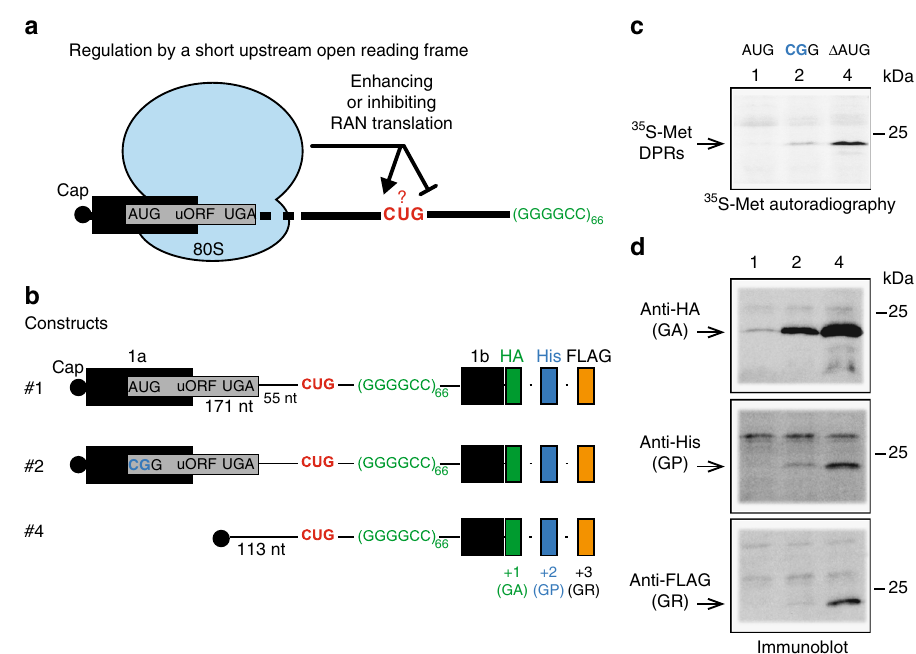
Fig. 5 RAN translation of G 4 C 2 repeats is down-regulated by a short upstream open reading frame (uORF). ( a ) Retention of intron 1 in C9ORF72 repeat- containing transcripts creates an uORF located 226 nucleotides upstream of the start CUG codon. This uORF may inhibit or enhance G 4 C 2 RAN translation. ( b ) To interrogate the regulation of RAN translation by this uORF, RNAs harboring the 5 ′ full-length sequence including C9ORF72 exon 1A (#1) and a AUG > CCG mutation in the uORF start codon (#2) were compared to RAN translation from RNA without the uORF (#4). Black boxes represent exons 1a and 1b and the gray box represents the uORF overlapping exon 1a and intron 1. ( c ) Translation in RRL system was performed in presence of [ 35 S]- methionine and capped RNA (#1, #2, or #4) followed by detection of [ 35 S]-methionine proteins by autoradiography. ( d ) Poly-GA, poly-GP, and poly-GR were detected by immunoblots using antibodies against HA-tag, His-tag, and FLAG-tag, containing the antisense (C 4 G 2 ) 66 repeat sedimented mainly in the light fractions or were associated to monosomes, consistent with a low translation ef fi ciency of the antisense transcripts (Fig. 7a, b; blue graph) 40 . Unexpectedly, treatment with edeine, that blocks the translation (Fig. 6b) and lead to the accumulation of β -globin mRNA in the light fractions (Fig. 7c, Supplementary Fig. 6f; light fractions 20 – 40, red graphs), did not prevent loading of polysomes on transcripts with 66 or 30 G 4 C 2 repeats (Fig. 7c, Supplementary Fig. 6f; heavy fractions 0 – 20, green and orange graphs). The same abnormal sedimentation of G 4 C 2 transcripts in heavy fractions was observed after treatment with GMP-PNP, a non-hydrolysable GTP analog that normally leads to the accu- mulation of the transcripts in the fraction corresponding to the 48S particles, showing that G 4 C 2 RNAs can recruit ribosomes in a translation-independent manner (Supplementary Fig. 6g). As expected, blocking ribosomal translocation with cycloheximide induced the accumulation of the control β -globin mRNAs in the fraction corresponding to monosomes 80S that are prevented from translocating after assembly (Fig. 7d, Supplementary Fig. 6h; red graphs). In contrast, inhibiting RAN translation with cyclo- heximide (Fig. 6b, Supplementary Fig. 6b – d) did not prevent ribosomal loading on expanded transcripts with 30 or 66 repeats (Fig. 7d, Supplementary Fig. 6h; heavy fractions 0 – 20, green and orange graphs). As expected the 80S peak was slightly increased consistent with a small proportion of expanded G 4 C 2 RNAs being associated with monosomes after cycloheximide treatment, but most transcripts remained present in the heavy fractions despite cycloheximide blockage of translation. Notably, radiolabeled (G 4 C 2 ) 66 transcripts were more abundant in heavy fractions when they were folded in presence of K + ions that stabilize G- quadruplex structures, comparatively to Na + and Li + ions (Sup- plementary Fig. 6i). Finally, to con fi rm that G 4 C 2 RNAs recruit